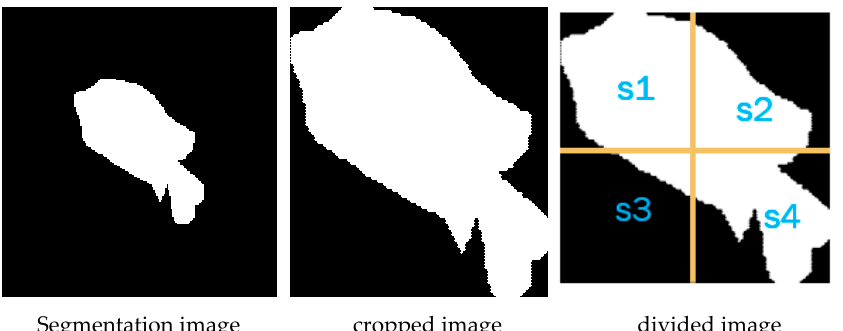
Figure 7. Estimation of fish orientation.